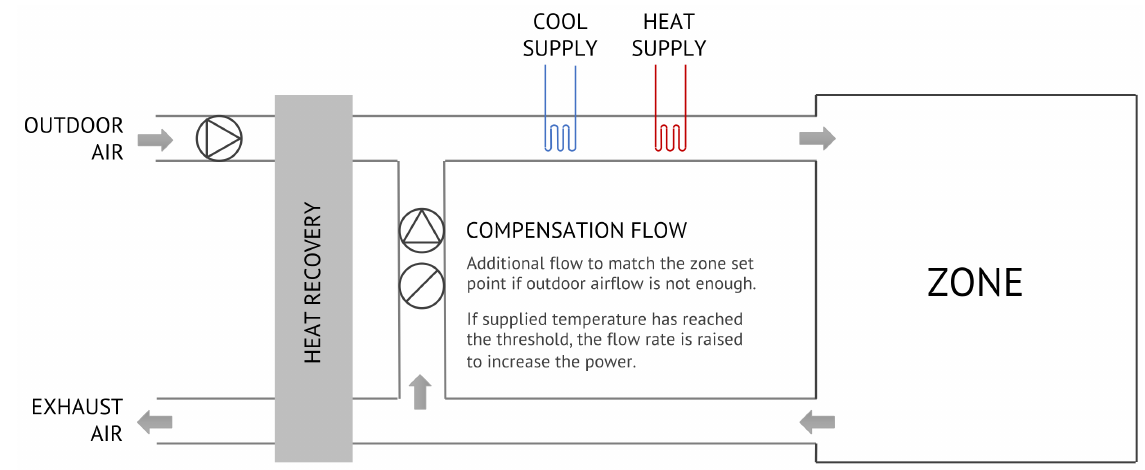
Figure 6. Model of ideal loads air system used to represent the HVAC